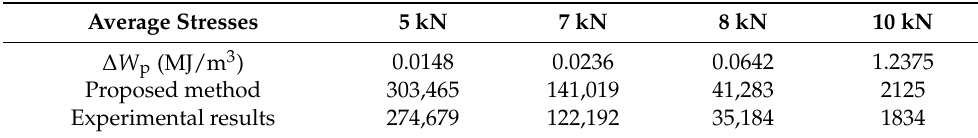
Table 10. Estimated and experimental results of the fatigue life of LC9 for different average stresses (the stress amplitude is 5 kN).